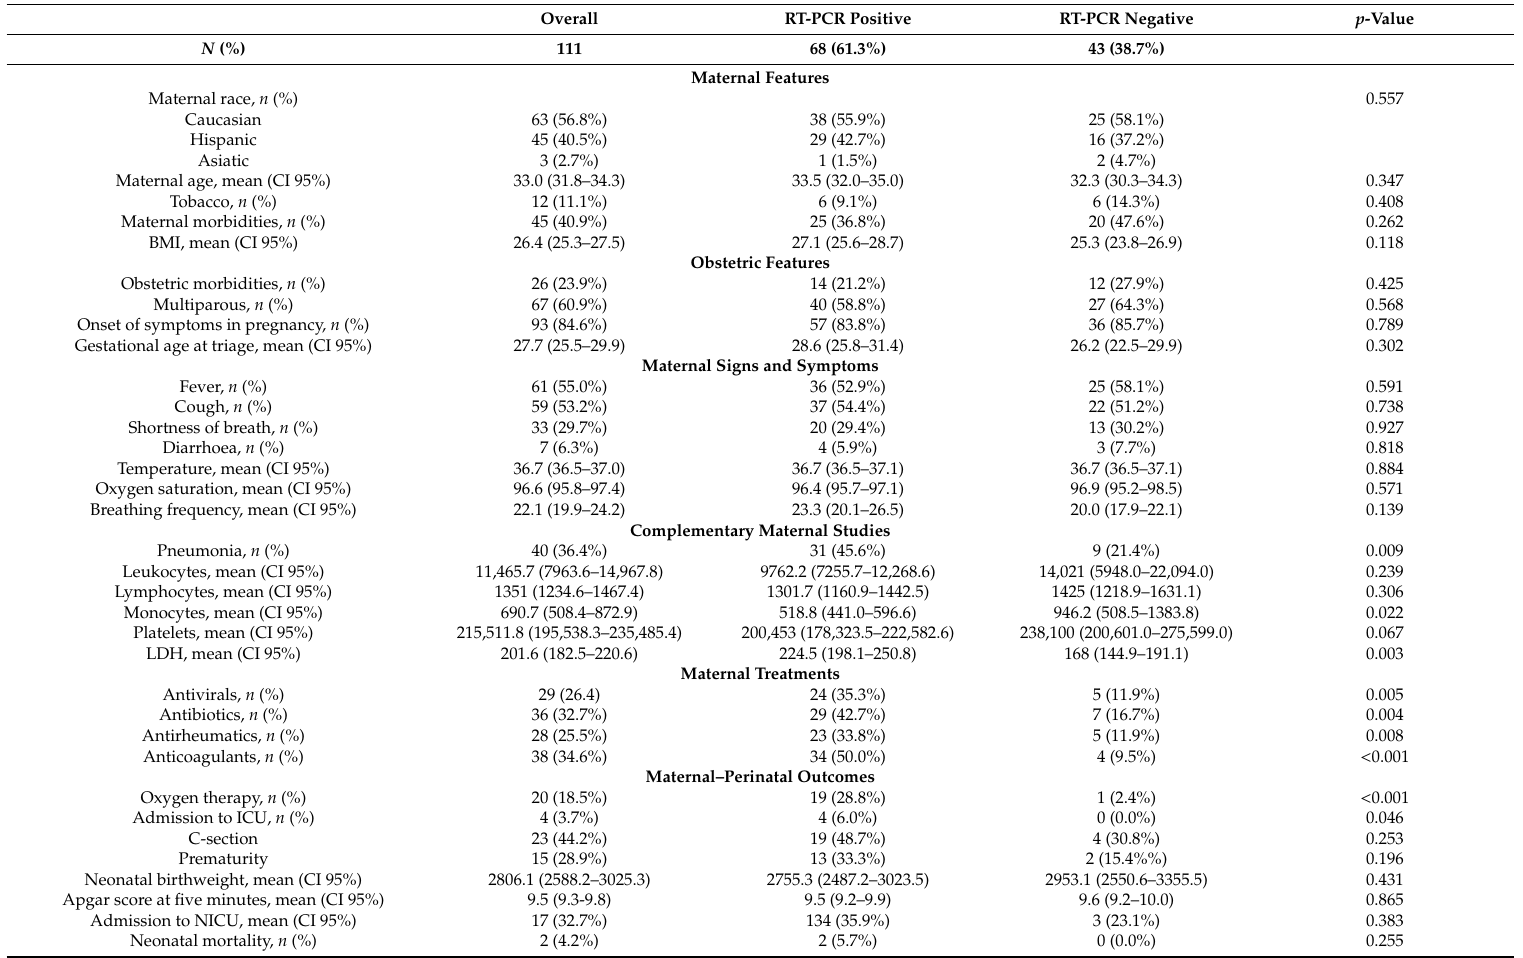
Table 1. Descriptive study of the overall sample and a comparative analysis based on the severe acute respiratory syndrome (SARS-CoV-2) RT-PCR results. Abbreviations: N —number of patients, %—percentage, CI—confidence interval, BMI—body mass index, ICU—intensive care unit, NICU: neonatal